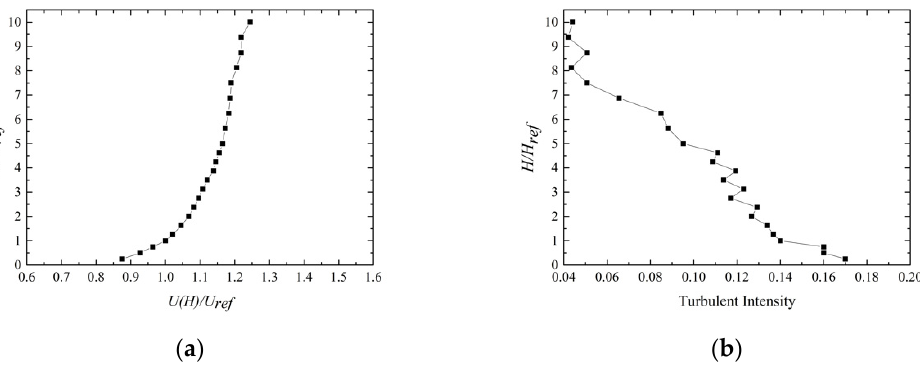
Figure 3. Inflow wind field of the experiment: ( a ) normalized mean wind velocity; ( b ) turbulent intensity.